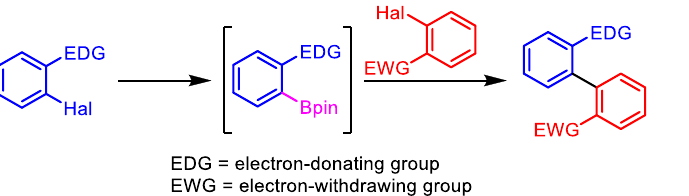
Figure 7. First employment of heterocycles in the one-pot MBSC sequence [35].